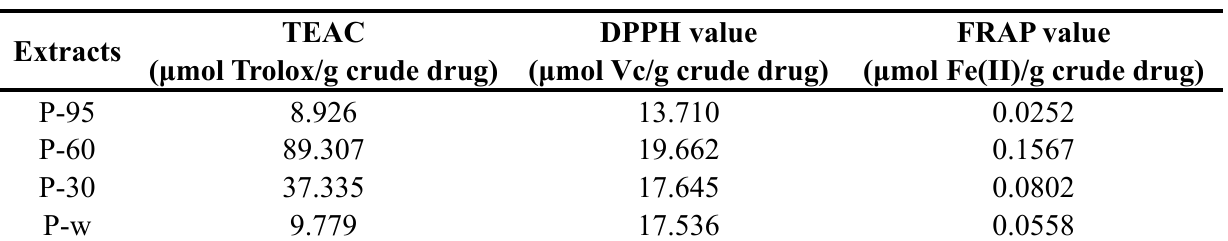
Table 1. Comparison on antioxidant ability of different PV extracts by TEAC, DPPH and FRAP methods (n = 3).